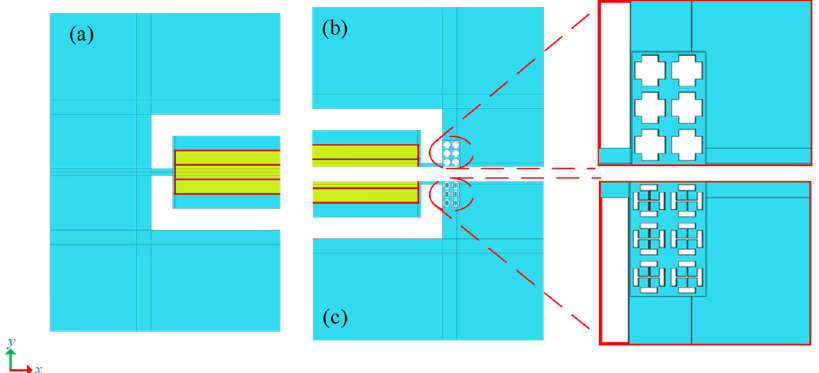
Figure 9. Simplified model for resonator simulation. ( a ) Model of a conventional TPOS resonator, shown as 1/2 the size of a conventional resonator. ( b ) 1/4 of the cross-like holey PnC resonator, ( c )